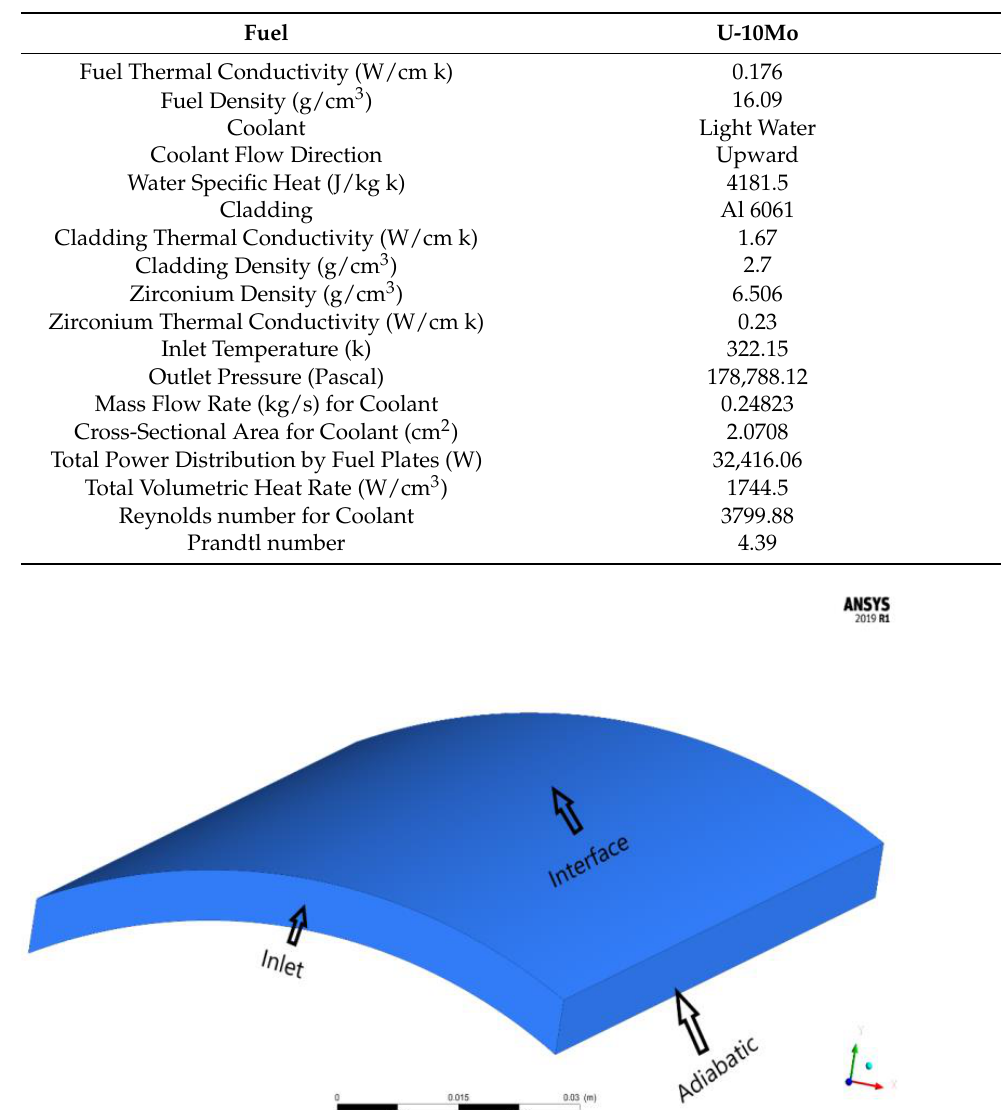
Table 2. Thermal hydraulic parameters.